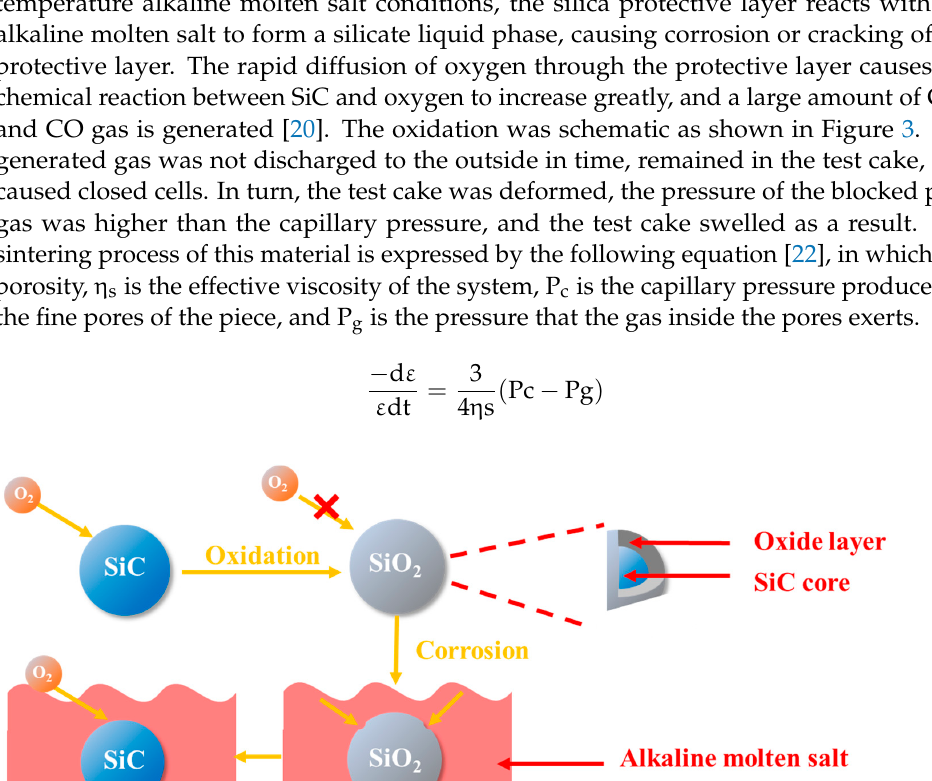
Table 4. Mix ratio of SiC foaming porous reconstructed steel slag.